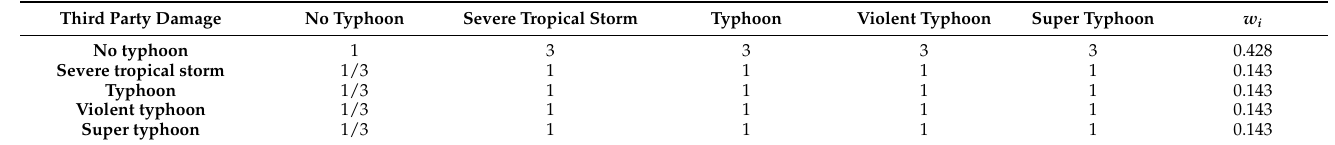
Table 4. Important degree judgment matrix of third-party damage under different typhoon intensity.